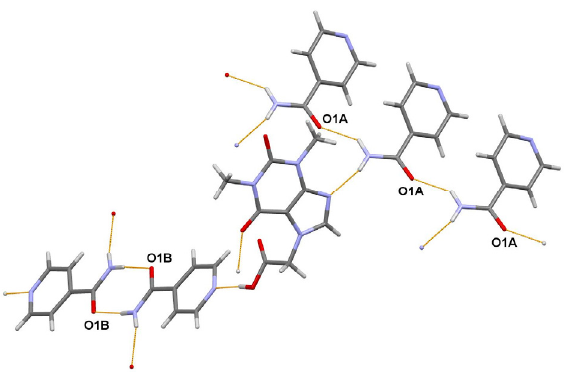
Figure 6. A portion of the crystal packing of ACF:INA (1:2) cocrystal showing the intermolecular N–H . . . N and N–H . . . O hydrogen bonds as thin orange lines.